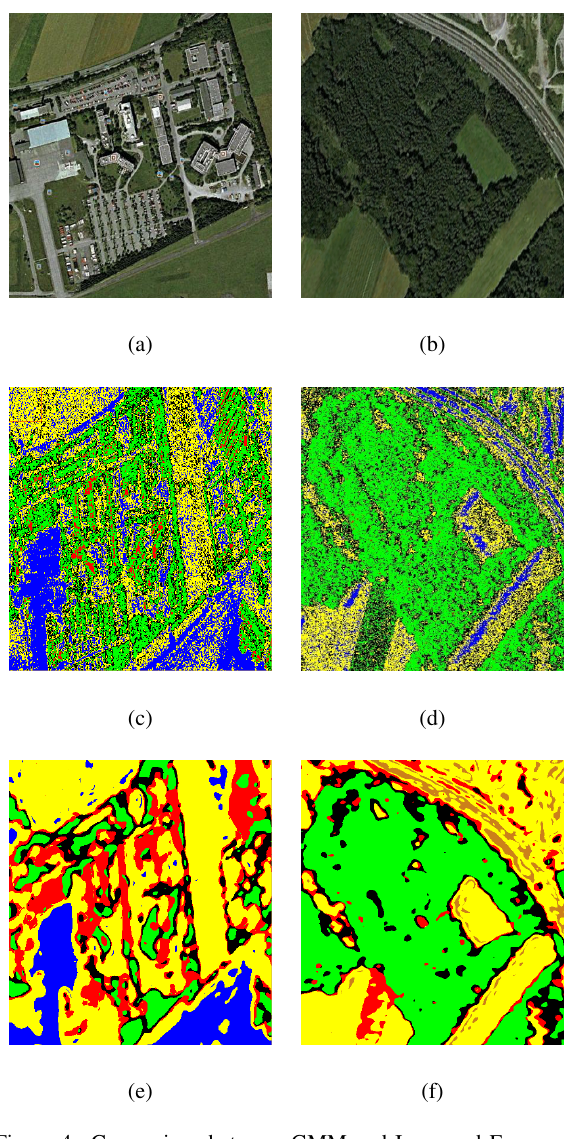
Figure 4. Comparison between GMM and Improved Freeman- GMM: Google Earth, (a) Urban area and (b) Forested area. Stan- dard GMM classification, (c) Urban area with and (d) Forested area. Improved Freeman GMM classification, (e) Urban area and (f) Forested